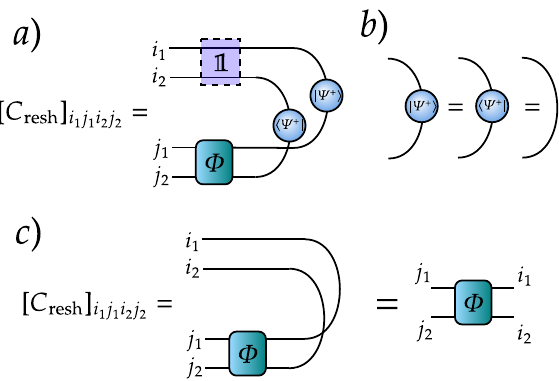
Figure 1: a) Diagrammatic representation of the Choi matrix. The block denoted by 1 represents the identity map in the definition of the Choi matrix. b) One can note that the state of a two-component quantum system | Ψ + 〉 can be seen as the identity matrix. c) Finally, we note that the Choi matrix is a quantum channel